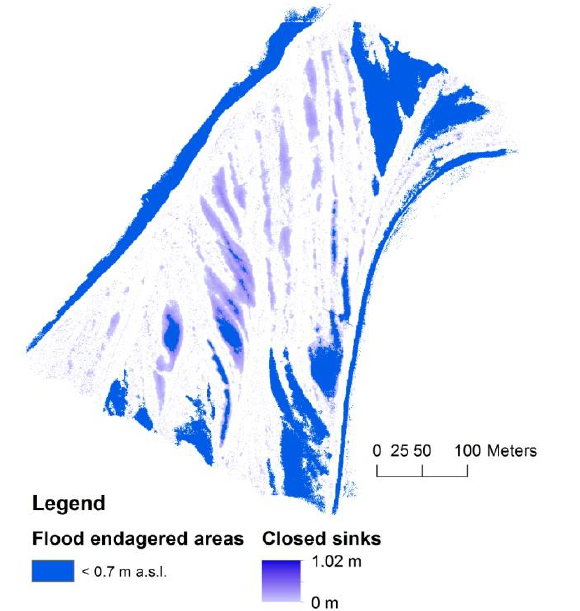
Figure 9: Flood endangered areas and closed sinks derived from the